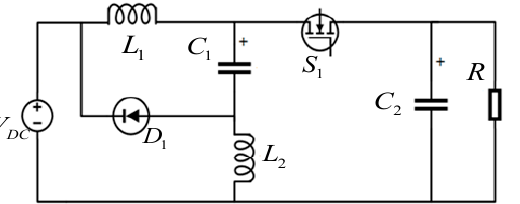
Figure 7. Boost converter circuit diagram.